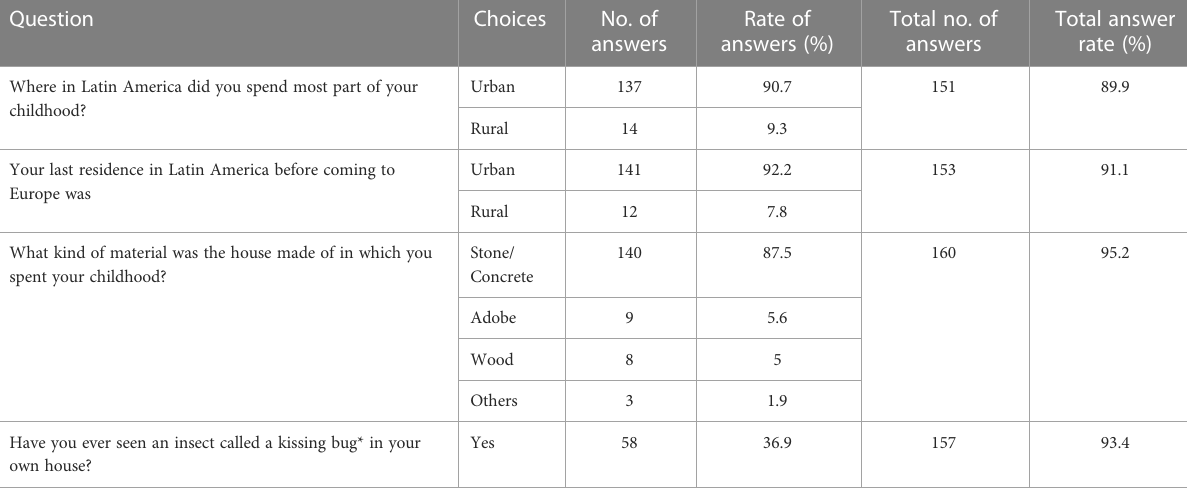
TABLE 1 Risk factors for Chagas disease related to location and type of housing.